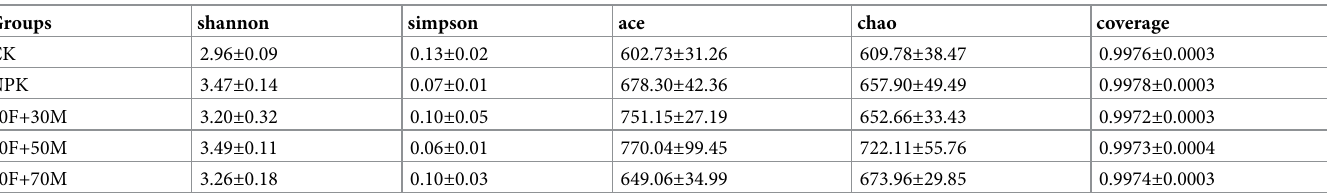
Table 4. Alpha diversity index of fungi in different groups.